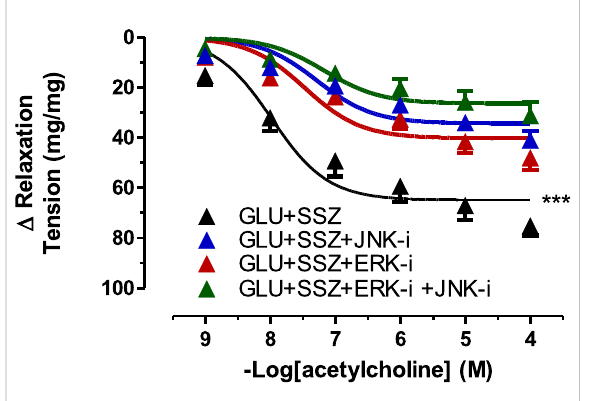
FIGURE 7 Effect of JNK and ERK inhibitors on acetylcholine induce tension in rat aortic rings. Concentration-response curve for cumulatively increaseing concentrations of acetylcholine induced relatation in rat aortic rings, express as delta tension the presence physiological glucose concentration (11.1 mM, Control), 44 mM glucose (GLU), 44 mM glucose and 300 mM sulfasalazine (GLU + SSZ), 44 mM glucose, 300 mM sulfasalazine and 10 µM JNK inhibitor SP600125 (GLU + SSZ + JNK-i), 44 mM glucose, 300 mM sulfasalazine and 10 mM ERK inhibitor U0126 (GLU + SSZ + ERK-i), 44 mM glucose, 300 mM sulfasalazine, 10 µM ERK inhibitor U0126 and 10 µM JNK inhibitor SP600125 (GLU + SSZ + ERK-i+JNK-i).Symbolsindicatemeanvalues±SEM,from9,12,11, 12, 11 and 10 aortic rings (Control, GLU, GLU + SSZ, GLU + SSZ + JNK-i, GLU + SSZ + ERK-i, GLU + SSZ + ERK-i + JNK i).*** p <